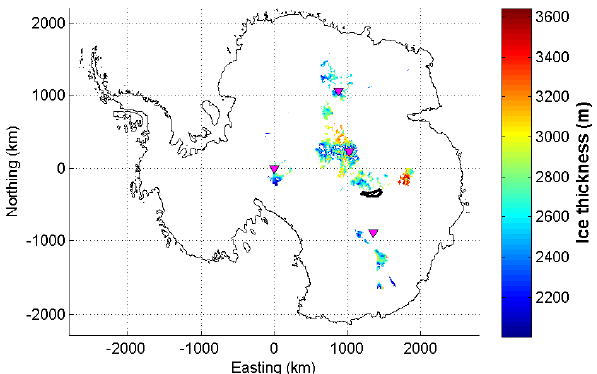
Fig. 5. Potential locations of cold basal conditions in areas with ice thickness H > 2000 m (colorbar) and horizontal flow speeds < 2 m yr -1 , for ∆ G > 5 mW m -2 and σ G < 25 mW m -2 , and as calculated with the simple model. Fig. 4. Scatter plot of 1G = G min − G versus σ G for all points with ice thickness H > 2000m and horizontal flow speed < 2myr − 1 . The color scale depicts ice thickness for each of the grid points. Negative values of 1G show where the pressure-melting point is reached, hence basal melt occurs. Positive values mean that the minimum required heat flow to reach the pressure-melting point is higher than the mean of the three GHF data sets. Points lying within the rectangle are likely to be cold-based, taking into account the variability of GHF. 28